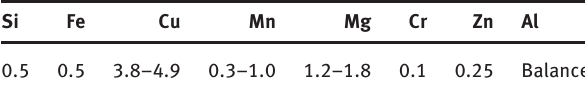
Table 1: Chemical composition of 6061Al alloy (mass fraction,